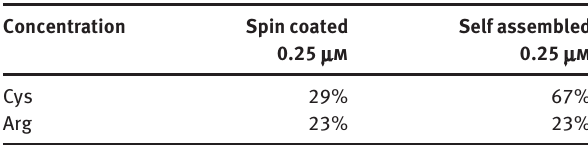
Table 1: Variation of percentage quenching of SPCE signal with concentration of amino acids for spin coating versus self-assembly